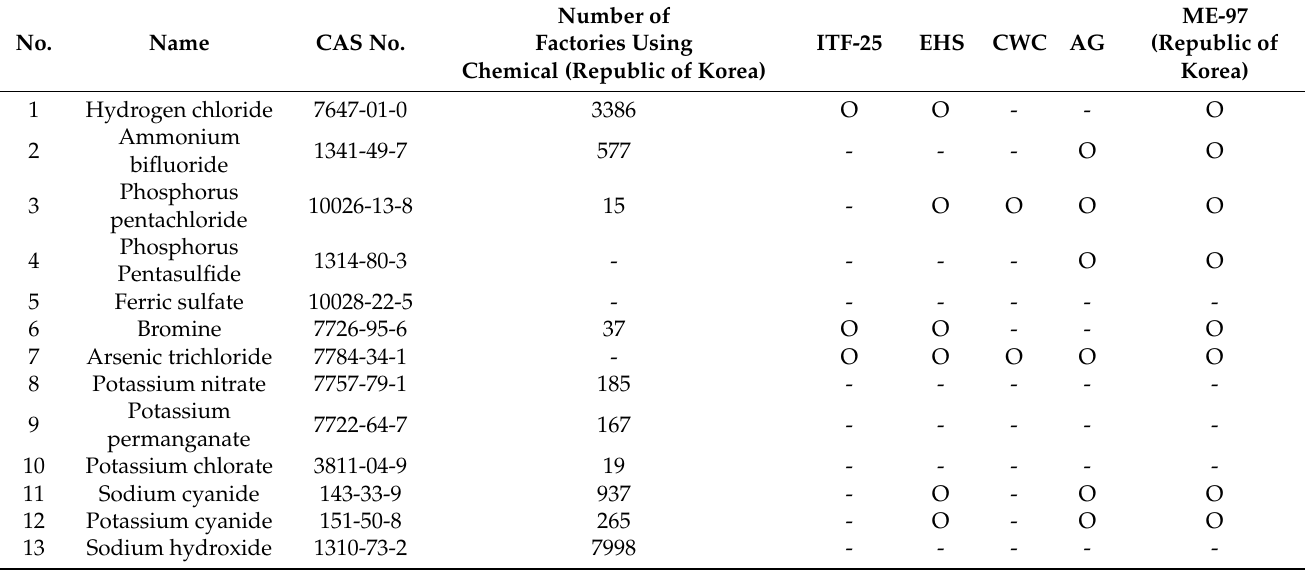
Table 1. Selected hazardous chemicals managed by the International Task Force (ITF-25), Extremely Hazardous Substances (EHSs) list, Chemical Weapons Convention (CWC), Australia Group (AG), and Ministry of Environment